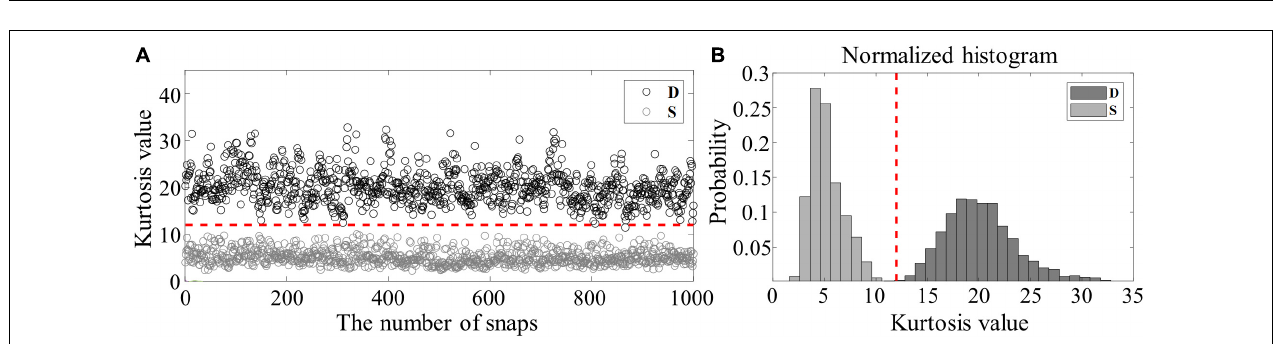
FIGURE 4 | (A) Time series of the direct arrival (D) captured in the bottom red box in Figure 3B . The red dashed line indicates the 1-ms smoothed kernel envelope of the snapping shrimp noise. (B) The waveform of snapping shrimp noise reflected from the sea surface (S), captured in the bottom white box in Figure 3B . Note the different pressure scales.